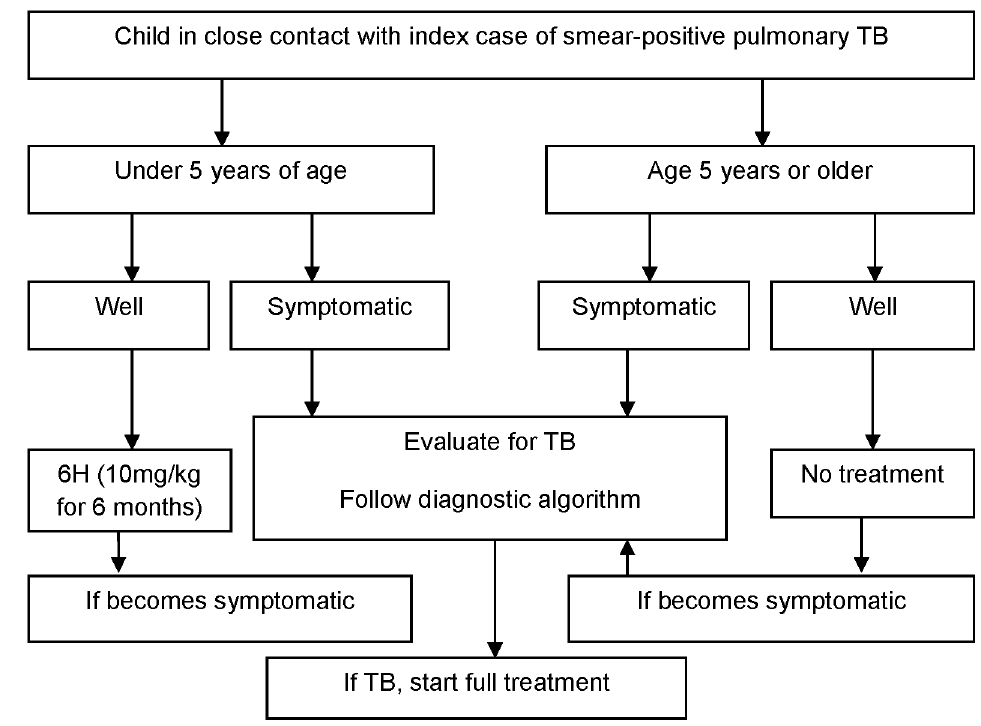
Fig 1. Algorithm for screening children in contact with an index